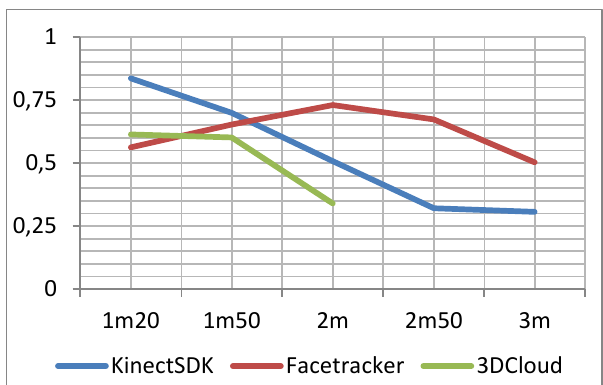
Figure 15. Mean correlation for the pitch function of the viewer distance from TV (in m).